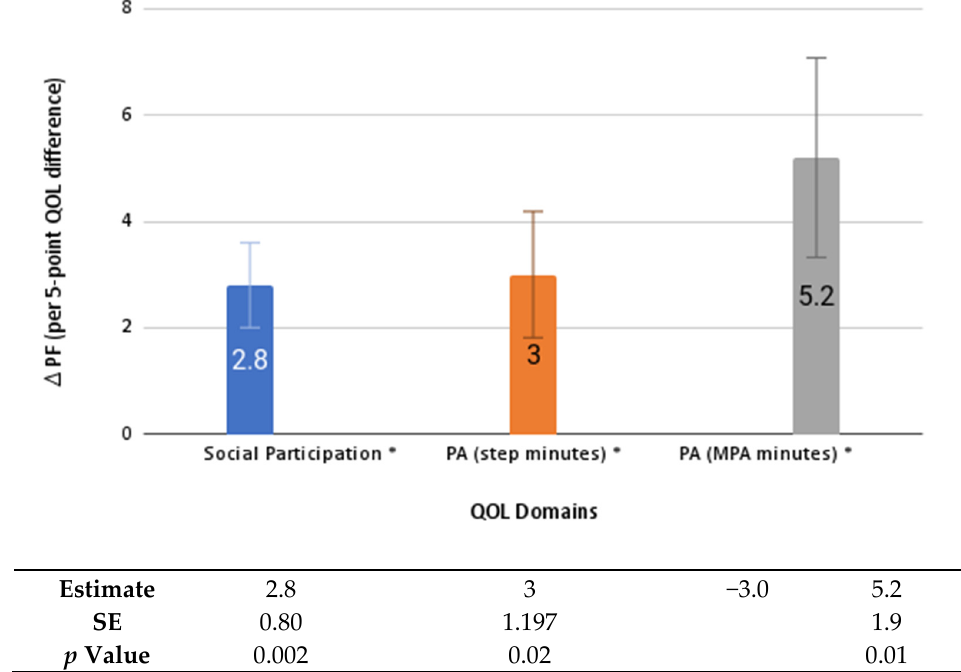
Figure 2. Change in physical function from baseline associated with baseline social participation and physical activity. Error bars indicate standard error; * indicates statistical significance ( p < 0.05). PF: physical function; PA: physical activity; MPA: moderate physical activity; QOL: quality of life; SE: standard error.